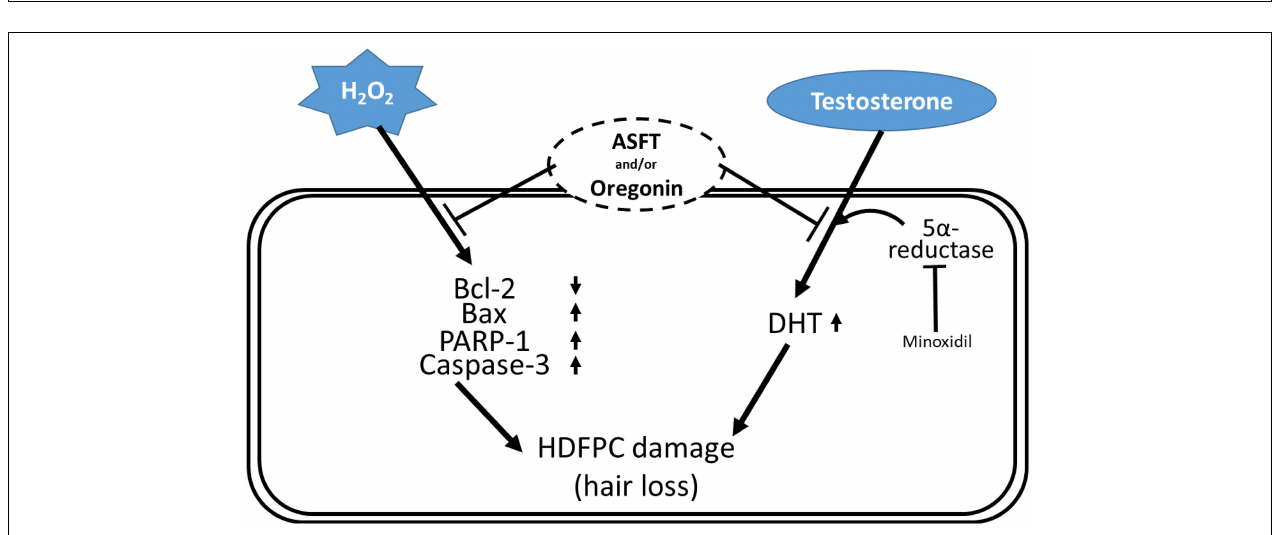
FIGURE 12 | Schematic diagram for the hypothetical action mechanisms of 60% ethanol extract from Alnus sibirica Fisch. ex Turcz and oregonin on oxidative stress-induced hair follicle dermal papilla cell damages and dihydrotestosterone-mediated hair